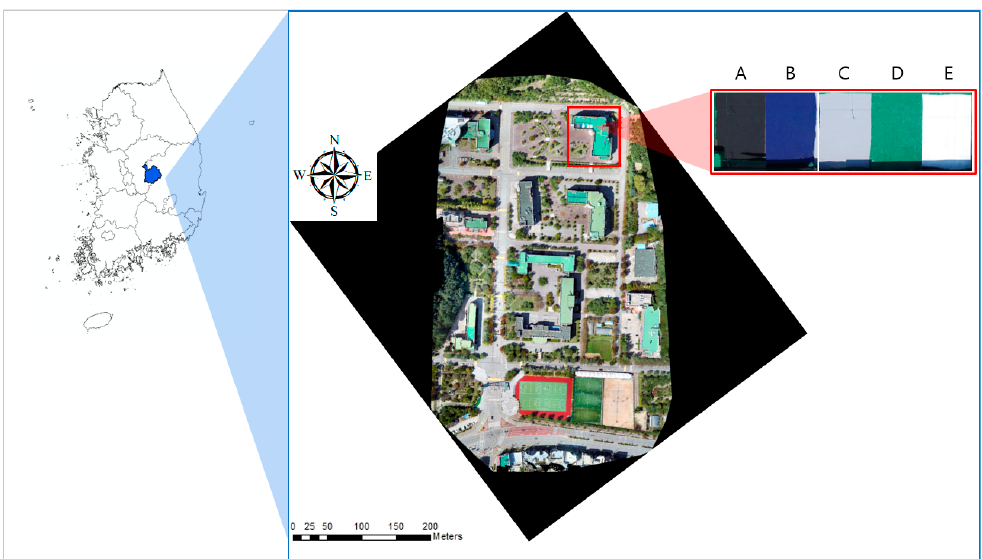
Figure 1. Study area (2559, Gyeongsang-daero, Sangju-si, Gyeongsangbuk-do, Republic of Korea).